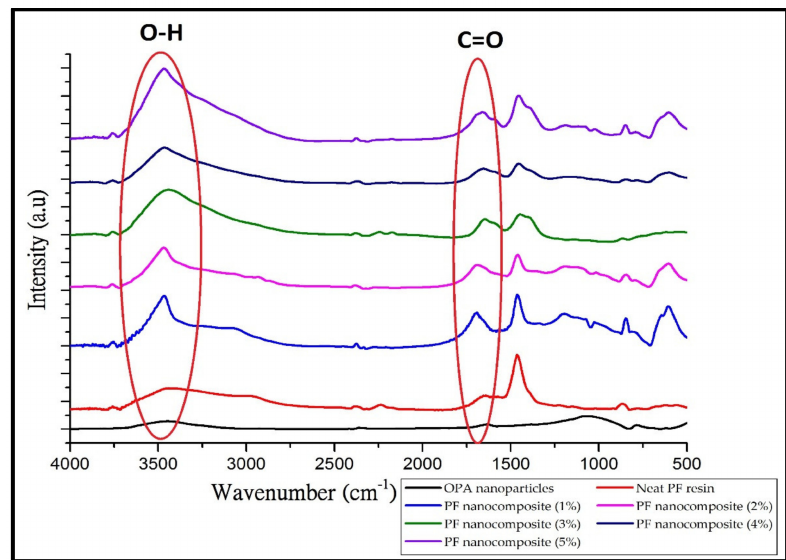
Figure 3. FT-IR spectra of neat PF resin, OPB nanoparticles, and PF nanocomposite-filled OPB nanoparticles (1% to 5%).